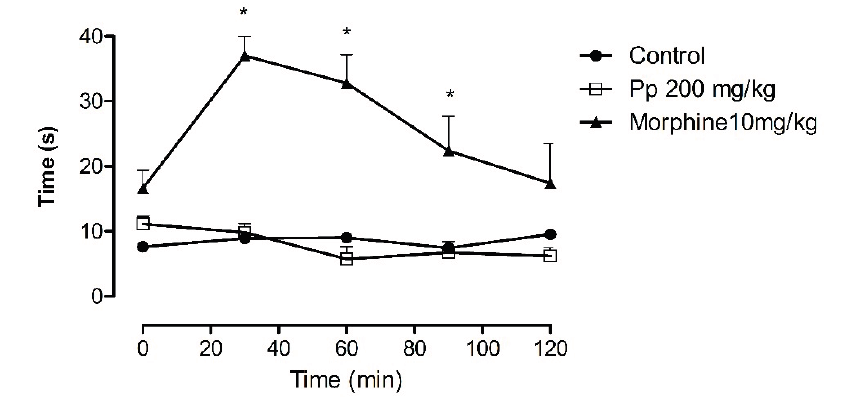
Figure 5. Hot plate test. Time-course of the effects of Pp-oil on thermal nociception. Abscissa time (min) after Pp-oil (oral), morphine (s.c.). Ordinate latency time (s) for the response to thermal stimulation (55 ± 0.5 °C, Mean ± s.e.m., n = 5) for each Pp-oil dose.